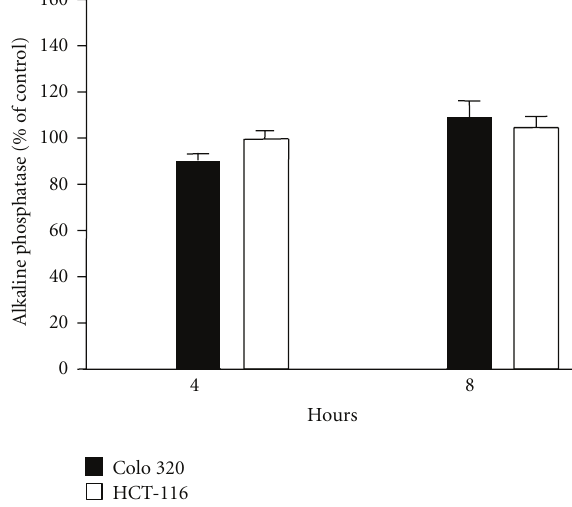
Figure 4: DIM treatment e ff ect on alkaline phosphatase activity. Alkaline phosphatase activity (di ff erentiation factor of colon cells) was detected after 4 and 8 hours of treatment. The results are presented as percentage of control and expressed as means ± SD of three independent experiments. ∗∗ P value <